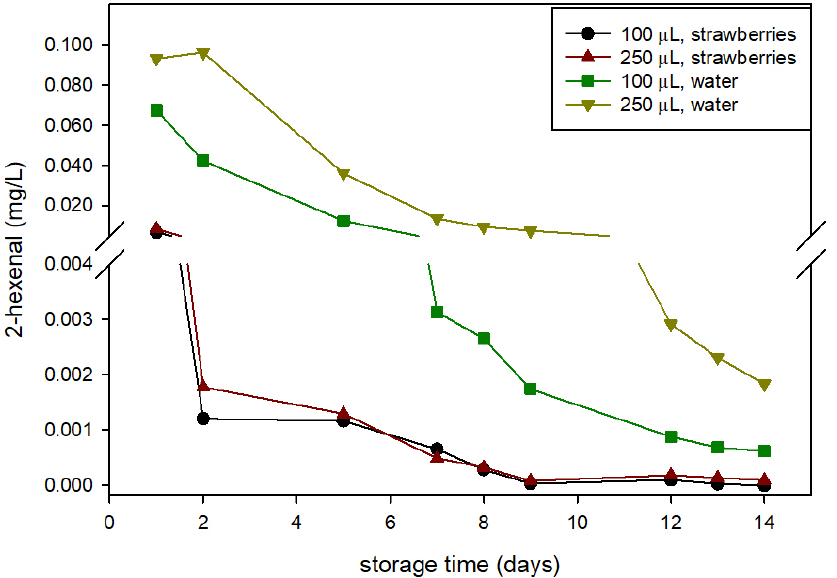
Figure 3. Concentration of trans-2-hexenal (HXAL) in the headspace (HS) of different active pack- aging with strawberries and with water.